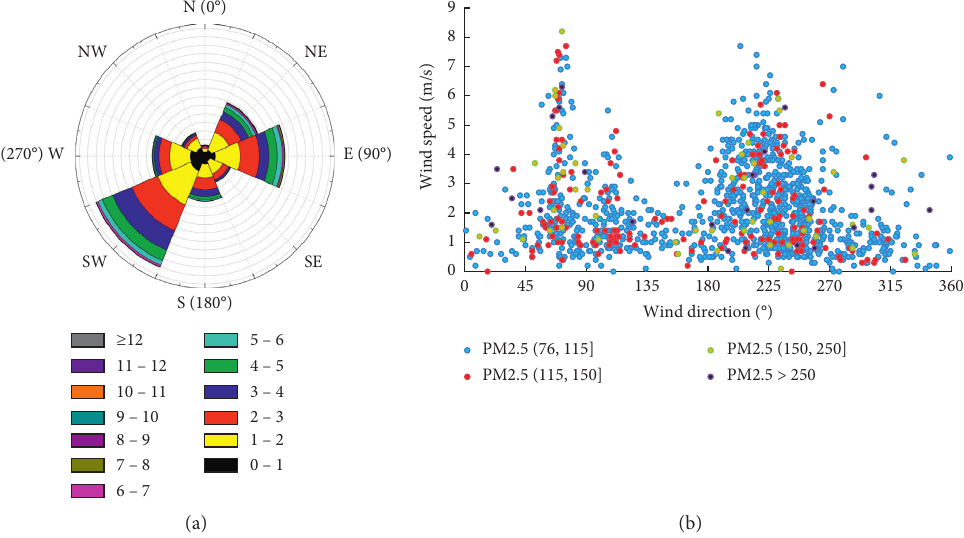
Figure 11: The wind rose diagram at Qinhuangdao. (a) The relationship between PM2.5, (b) mass concentration, and wind speed and wind direction in